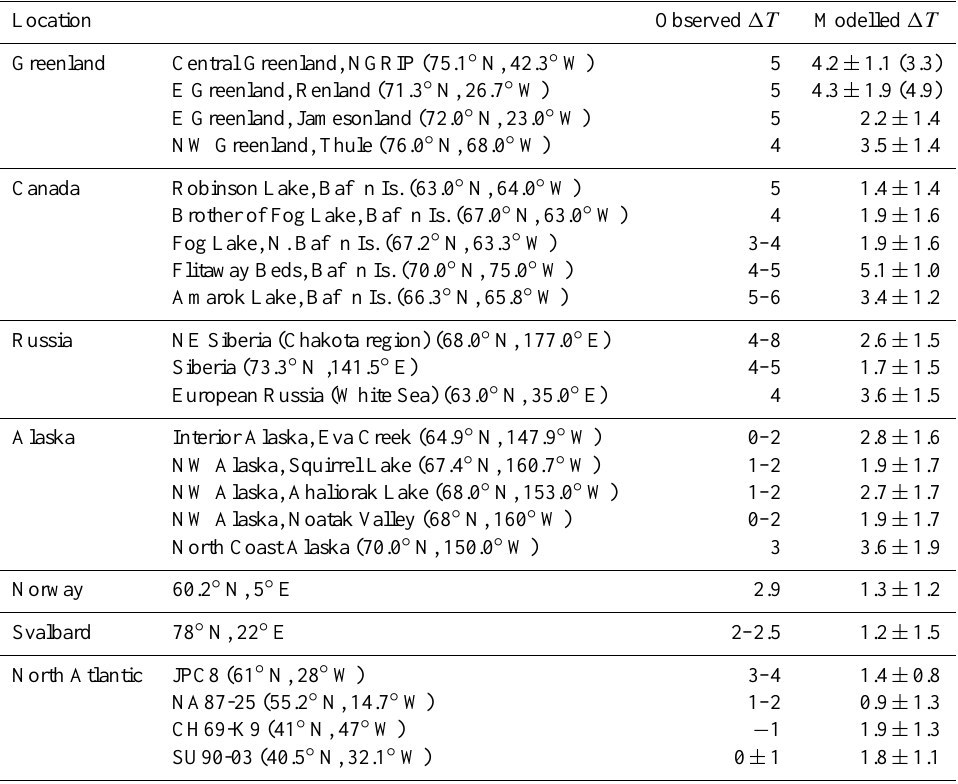
Table 3. Comparison of LIG temperature anomalies (in ◦ C) derived from palaeoproxy reconstructions (CAPE members, 2006) with the sim- ulated maximum LIG summer temperature anomalies from HadCM3. All locations described are shown in Fig. 5. The values in parentheses for comparison with ice core data on Greenland (NorthGRIP and Renland) refer to the warmest annual precipitation-weighted temperatures. Values derived from HadCM3 include ± 2 σ